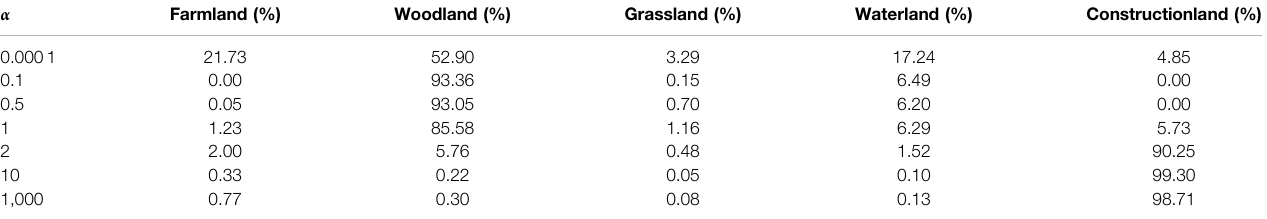
TABLE 3 | Changes in the proportion of land use in ecological priority areas under different scenarios. α Farmland (%)